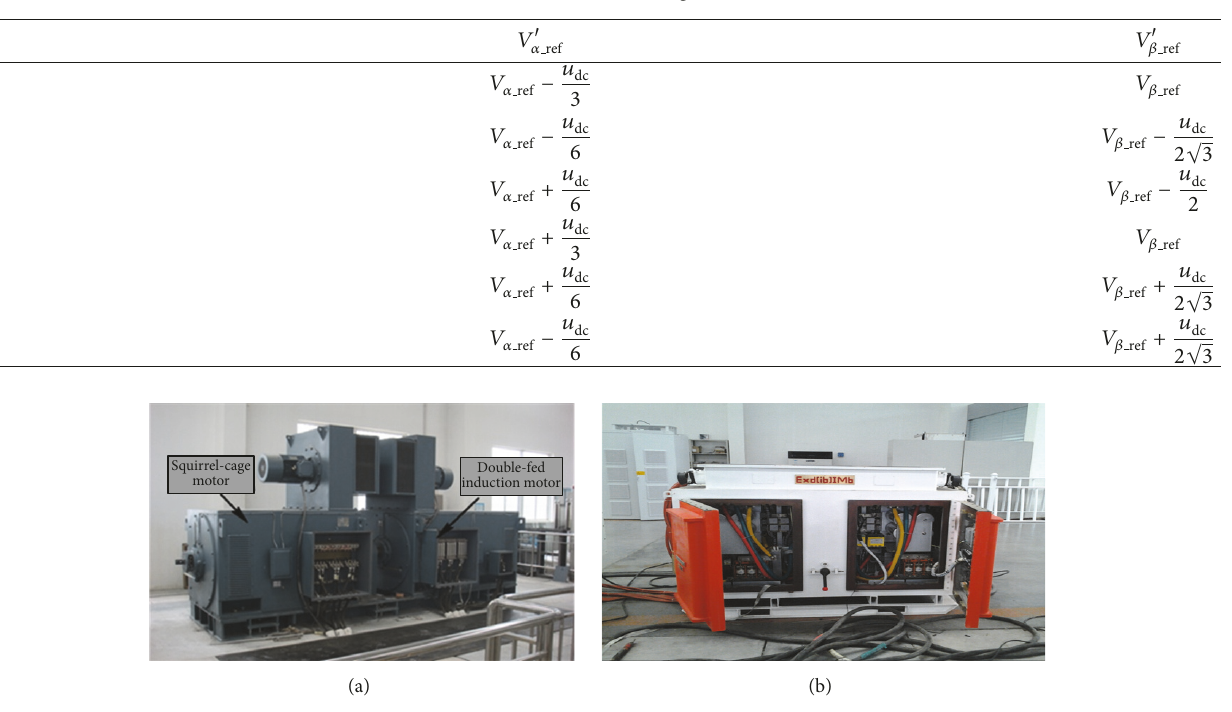
Table 2: Vector translations of reference voltages under different 𝑆 values.